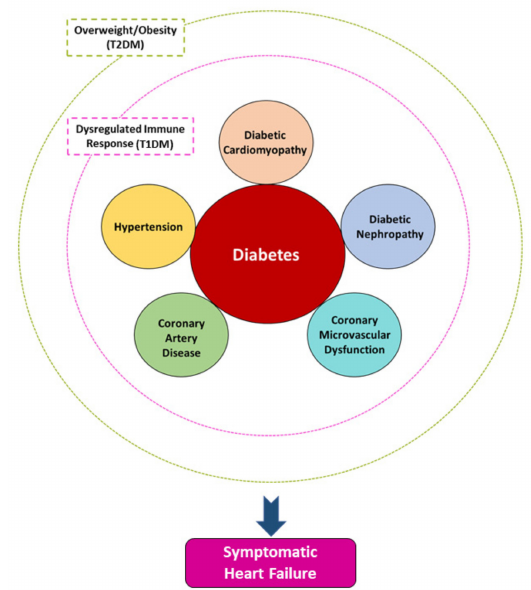
Figure 1. The pathogenesis of new-onset heart failure in diabetes mellitus (DM) is complex and has been largely attributed to the direct toxic effect of hyperglycemia and relevant metabolic effects on the myocardium (diabetic cardiomyopathy) as well as the frequently coexisting hypertension, coronary artery disease, coronary microvascular dysfunction, and diabetic nephropathy. In patients with type 1 DM, HF develops in the setting of a dysregulated immune response, whereas in most patients with T2DM, against a background of